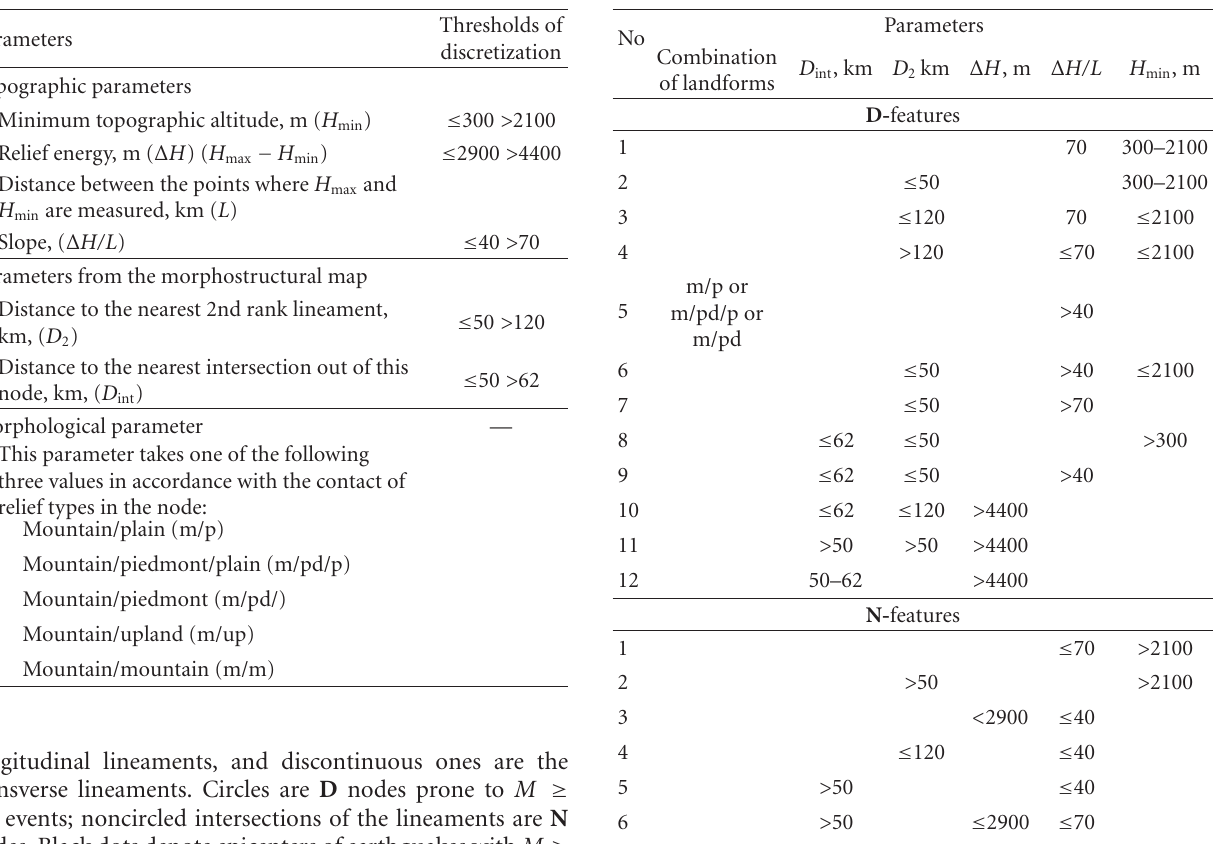
Table 1: Parameters used for recognition and their thresholds of discretization.